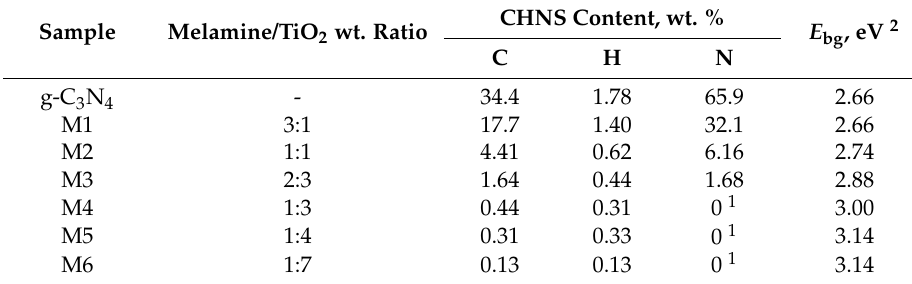
Table 1. Sample nomination, melamine/TiO 2 weight (wt.) ratio, results of CHNS analysis, and E